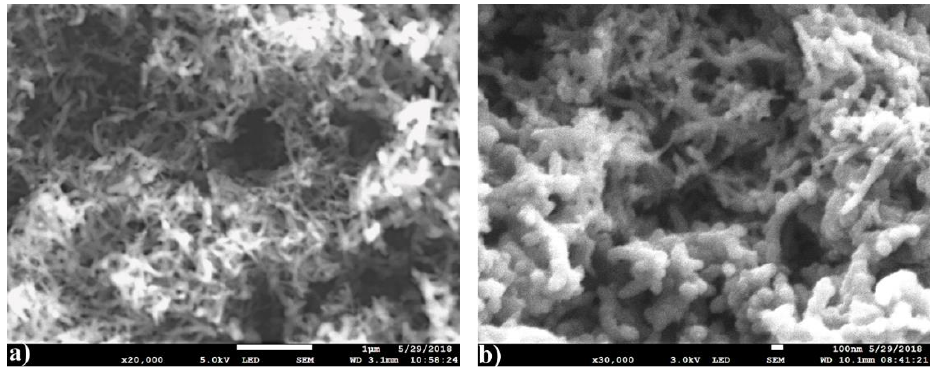
Figure 7. SEM micrographs of PANI: ( a ) 20,000 and ( b ) 30,000 magnification.